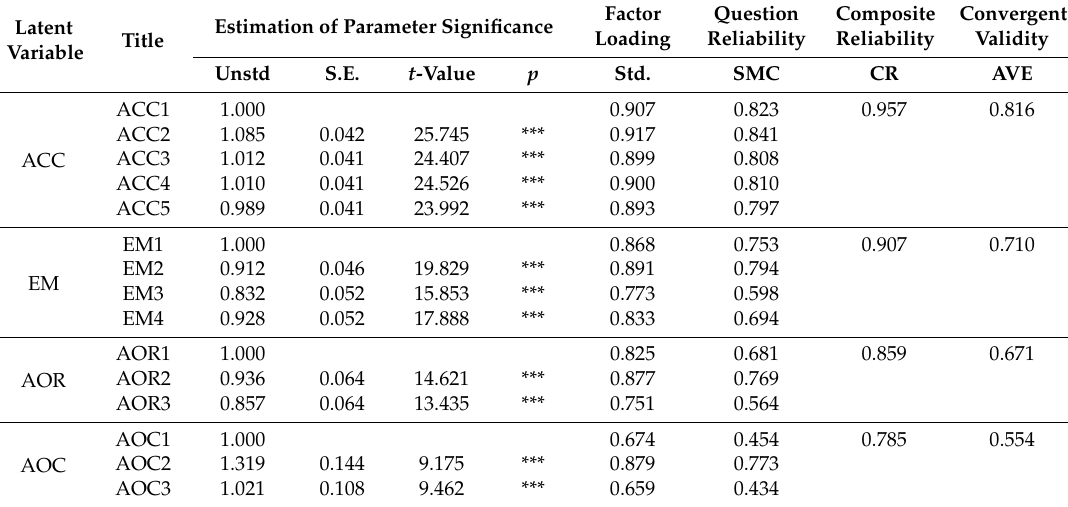
Table 7. Results for the measurement model.